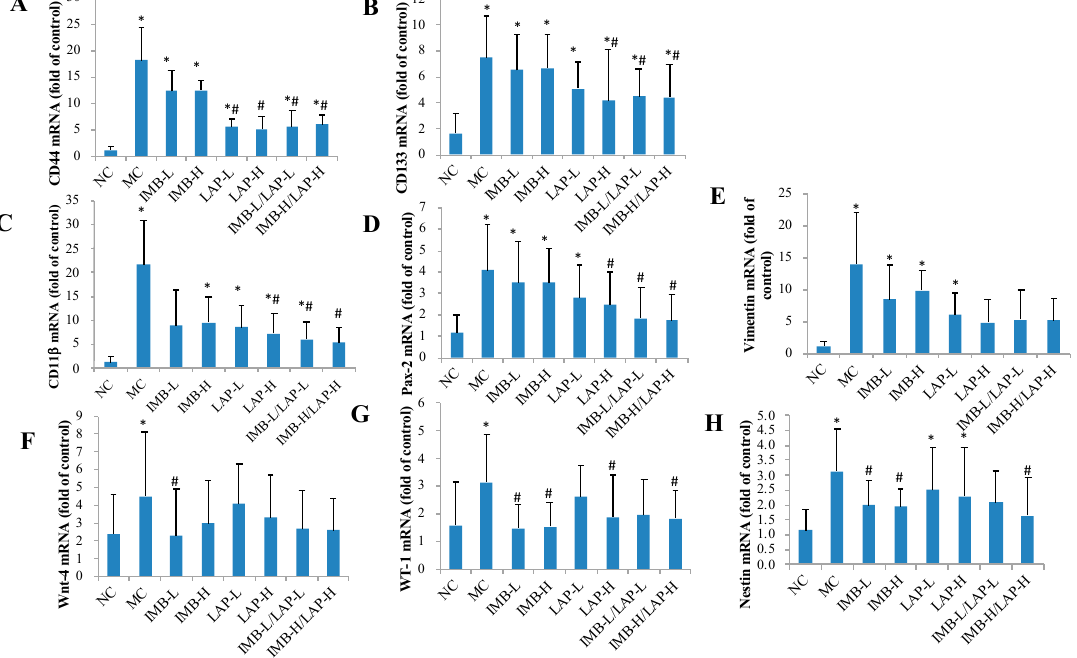
Figure 5. E ff ects of IMB and LAP on the gene expression levels of stem cells markers in kidney. CD44 ( A ), CD133 ( B ), CD11 β ( C ), Pax-2 ( D ), vimentin ( E ), Wnt-4 ( F ), WT-1 ( G ), and nestin ( H ). Values are expressed as Mean ± SD, n = 8. Within each panel, values with the superscript symbols “*” and “#” are significantly di ff erent from the NC and MC, respectively, p at least <